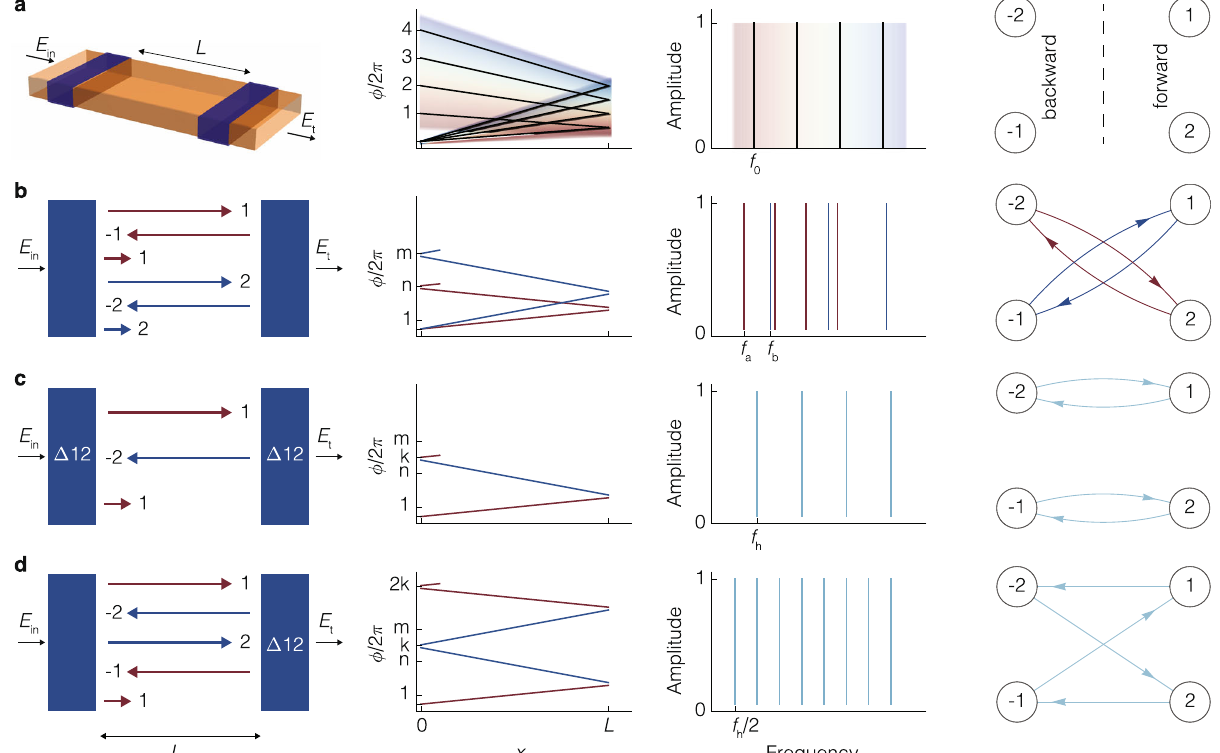
Fig. 1 | The operating principle underlying cascaded-mode resonances. a From left to right: First, a visualization of traditional resonator of length L . Second, the phase shift as a function of distance x for a resonator of length L for different longitudinalmodesofindex m :afteraroundtrip2 L theaccumulatedphaseis m 2 π . Third,theresonancespectrum,whichcorrespondstothefrequenciesforwhichthe round-trip phase Δ ϕ equals a multiple of 2 π . b In many resonators, different transverse modes contribute to different spectra because their effective refractive indices inside the resonator differ. The different effective indices determine the different slopes of the lines in the second column, which results in spectra with different fundamental modes ( f a , f b ) and mode spacings in the third column. c A cascaded-moderesonator(theblueregionsaremode-convertingmirrors)inwhich the two transverse modes, labeled 1 and 2, couple into one supermode, with fun- damental frequency f h . The round-trip phase and the free spectral range are partly